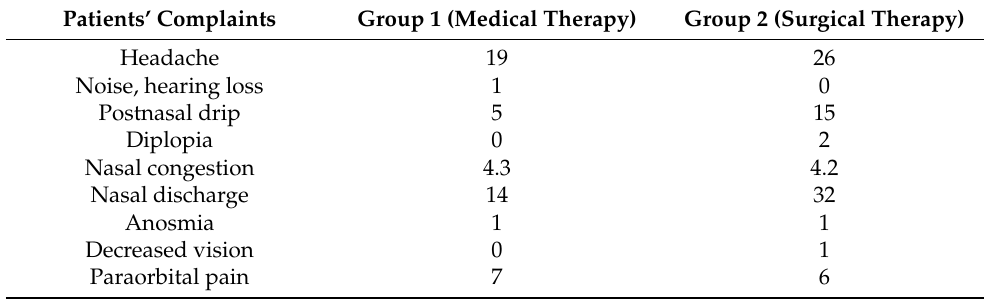
Table 2. Complaints of patients with ISS.